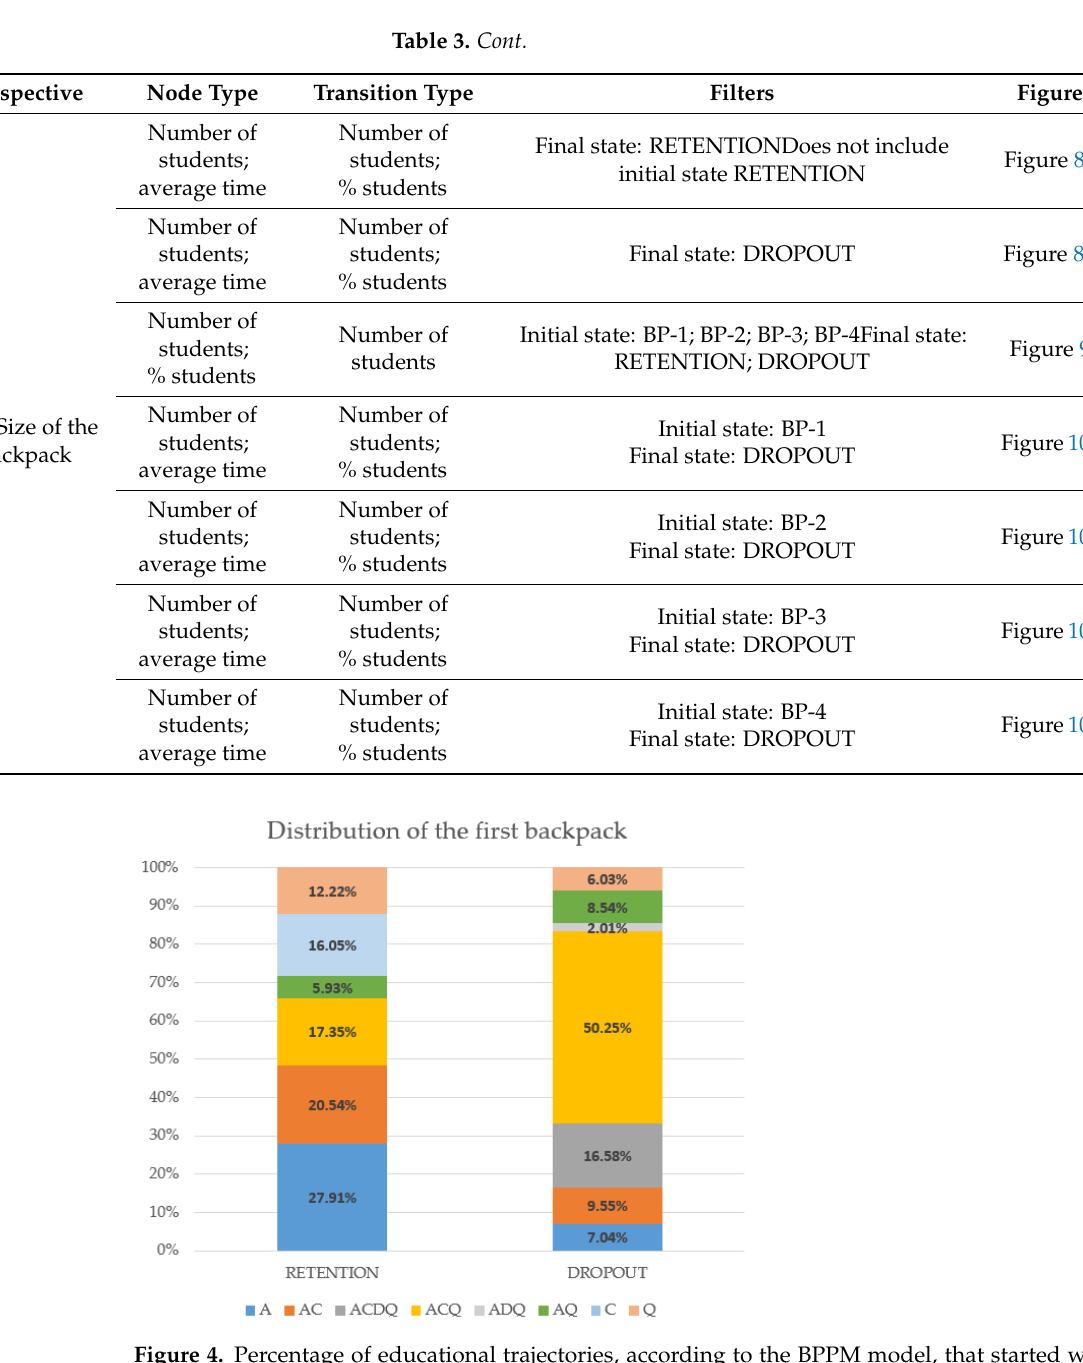
Figure 5. Average time (in days) that the students stay in each backpack. The graph considers only the most frequent variants for each model, corresponding to 80% of the students. The RETENTION columns consider only students who had a backpack and emptied it. The DROPOUT columns consider only students who had a backpack, were not able to empty it and finally dropped out.